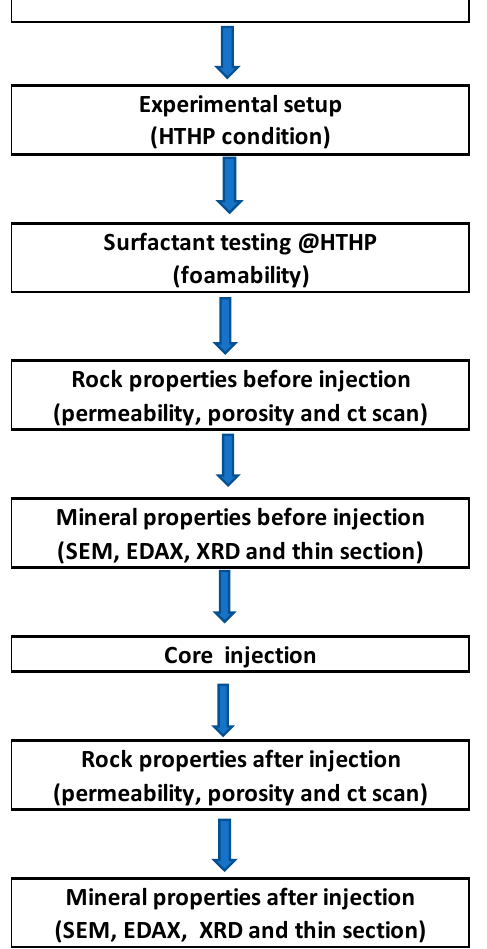
Figure 2. Flowchart of the entire experimental process.